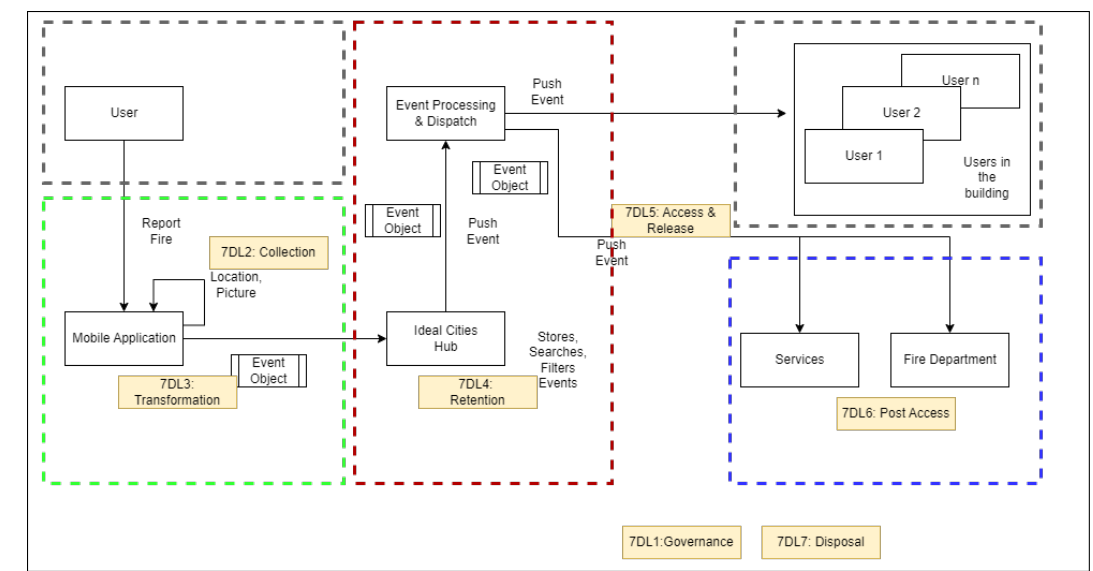
Figure 4. Data flow diagram for the worked